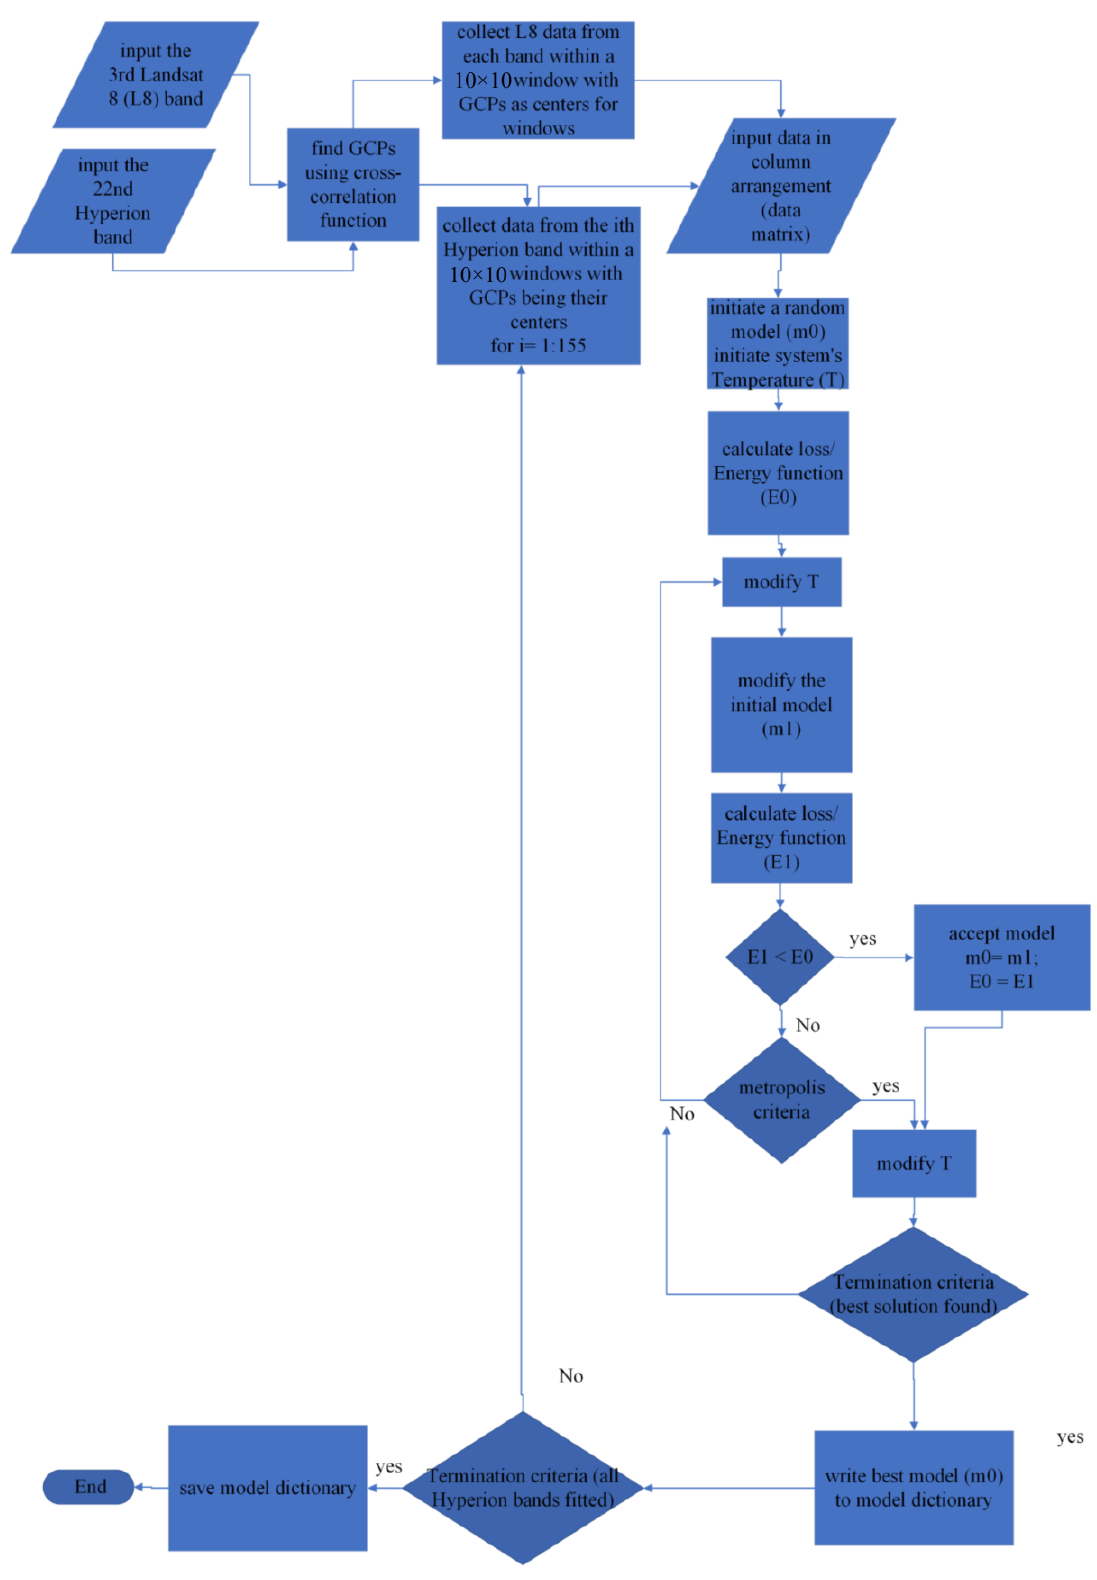
Figure 1. SAM-HIT workflow for the first two steps: fitting the best model and writing to the model dictionary.